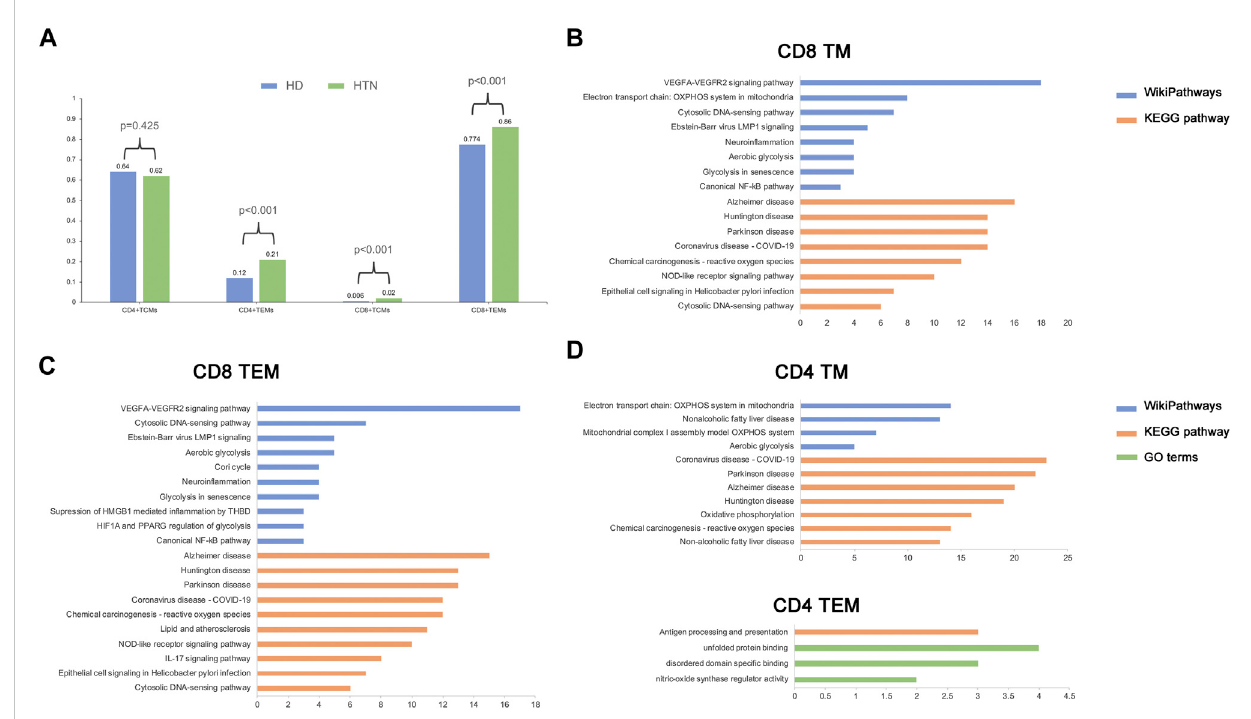
FIGURE 2 Alterationofcellfrequencyandactivatedpathwaysduringhypertension. (A) Single-cellRNAsequencingassaycomparingcellcompositionbetween healthy and hypertensive participants. (B – D) Top enriched pathways of differentially expressed genes (DEGs) in CD8 TM (B) , CD8 TEM (C) , CD4 TM, and CD4 TEM (D)